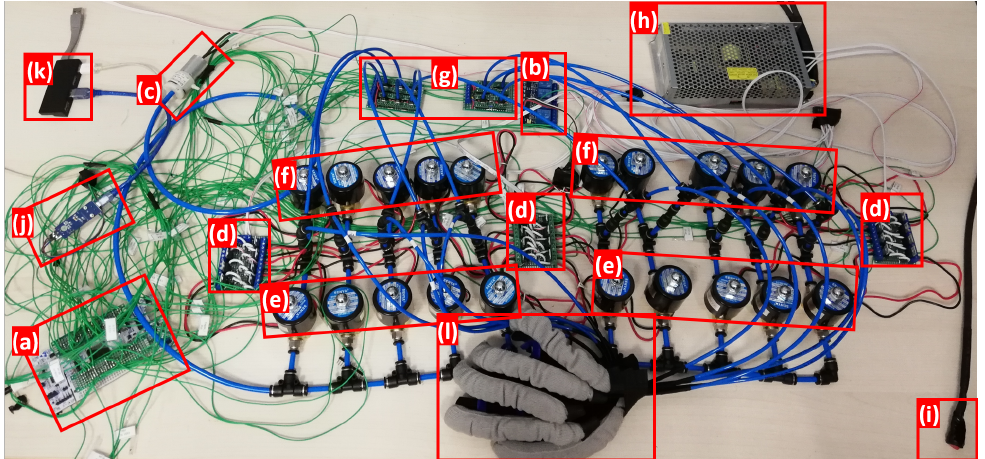
Figure A1. Air pressure control system components, which include: ( a ) Microcontroller. ( b ) Relay card. ( c ) Air pump. ( d ) Valve driver cards. ( e ) Inflate solenoid valves. ( f ) Deflate solenoid valves. ( g ) Pressure sensors. ( h ) Power supply. ( i ) Emergency stop switch. ( j ) USB to TTLconverter. ( k ) USB hub. ( l ) Soft robotic